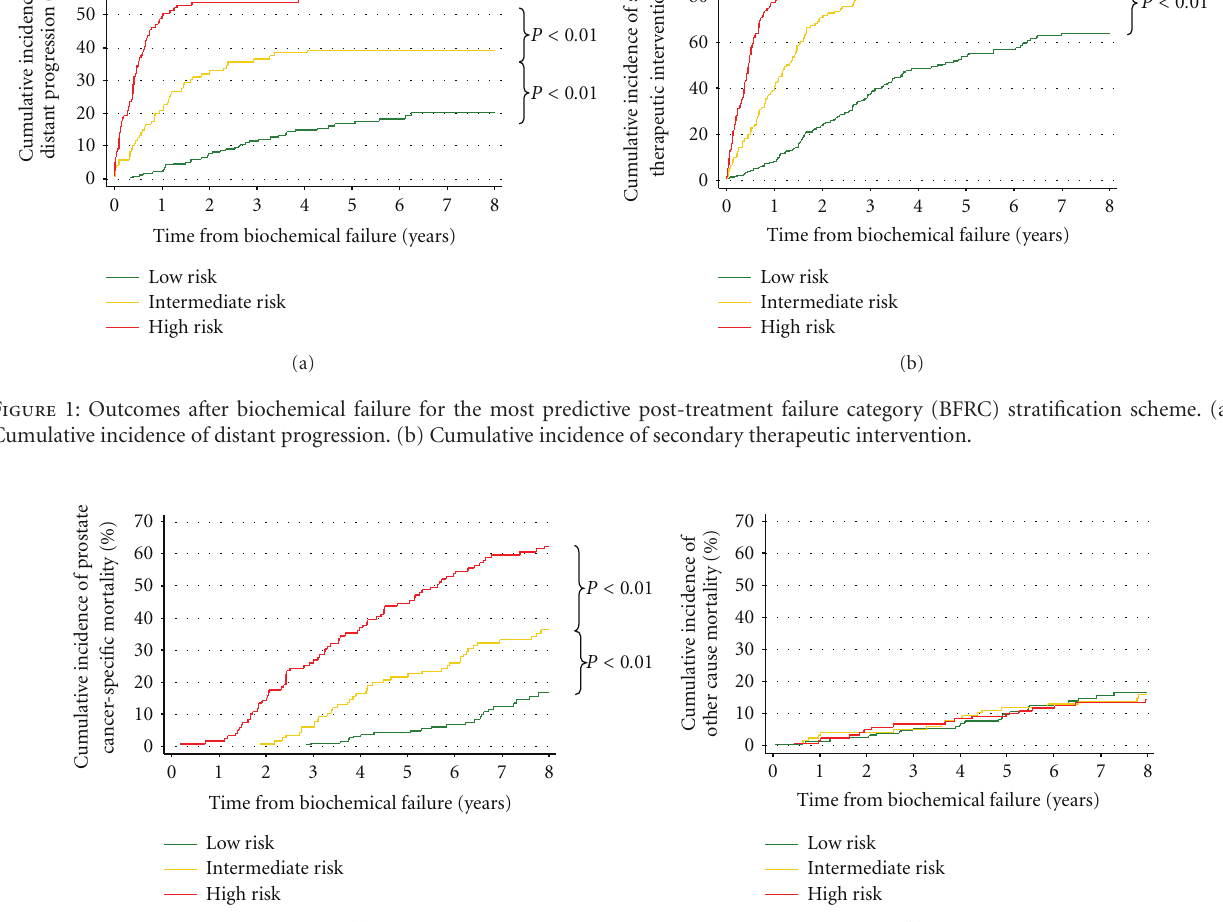
derived using 12 months of PSAs post-BF to calculate PSADT instead of 6 months of